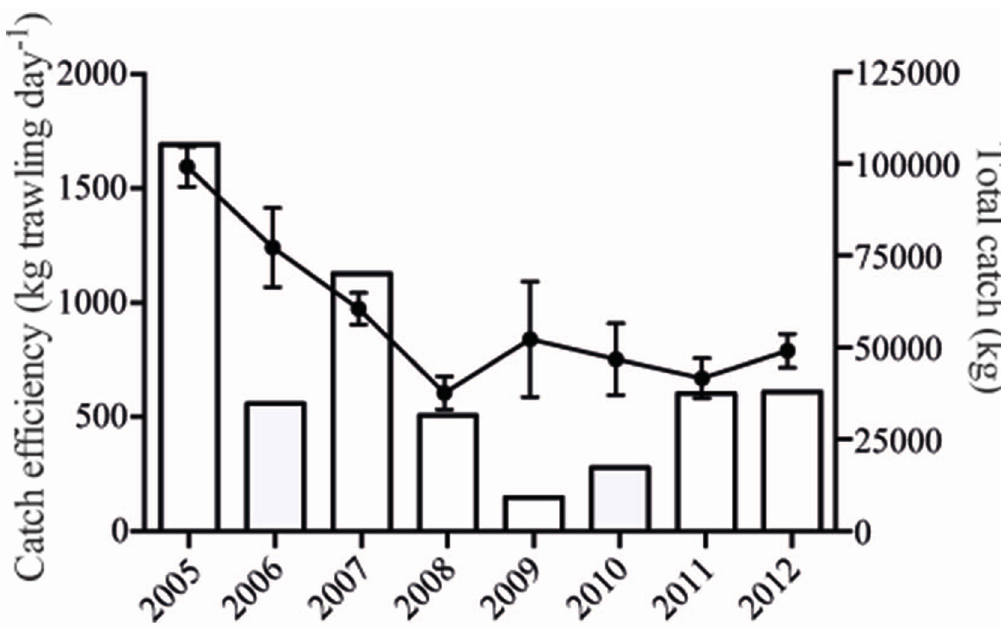
Figure 2. Total reported landings from the trawl per year (bars) and average catch efficiency (kg trawling day 2 1 ) ± SE (line).